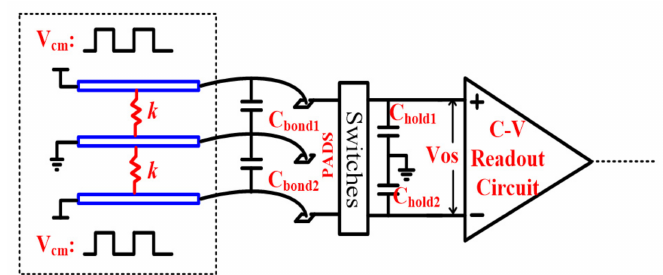
Figure 2. The MEMS F-C and interface connection.